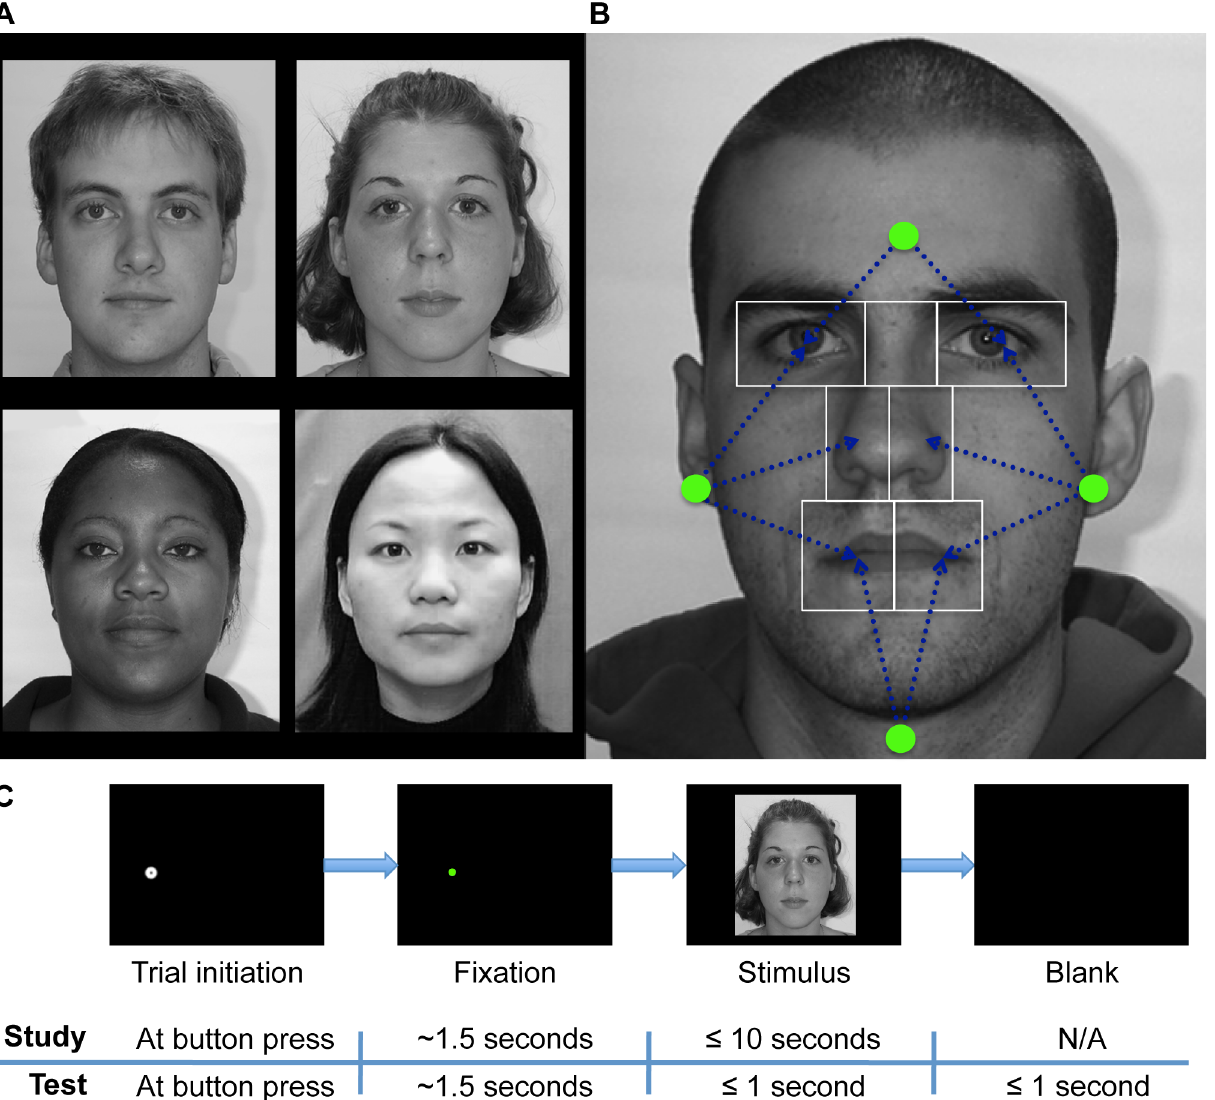
Fig 1. Study design. (a) Four example face stimuli. (b) AOIs for one face showing the calculation of start positions, which were determined separately for each face and defined relative to that face. Green dots schematically illustrate the potential start positions relative to the upcoming face. Left and right start positions were equidistant from centers of the nearest eye, nose and mouth AOIs. Upper and lower start positions were equidistant from the centers of the two eye or two mouth AOIs, respectively. Dotted blue lines schematically illustrate that the start positions were equidistant from the centers of the indicated AOIs. (c) Trial sequences in study and test phases. A face was only presented if the participant successfully maintained fixation for a total of 1.5 seconds. After face onset in the study phase, participants were free to study the face for up to 10 seconds and pressed a button to begin the next trial. In the test phase, faces were presented for one second only and participants responded with button presses to indicate whether the face was ‘ old ’ or ‘ new ’